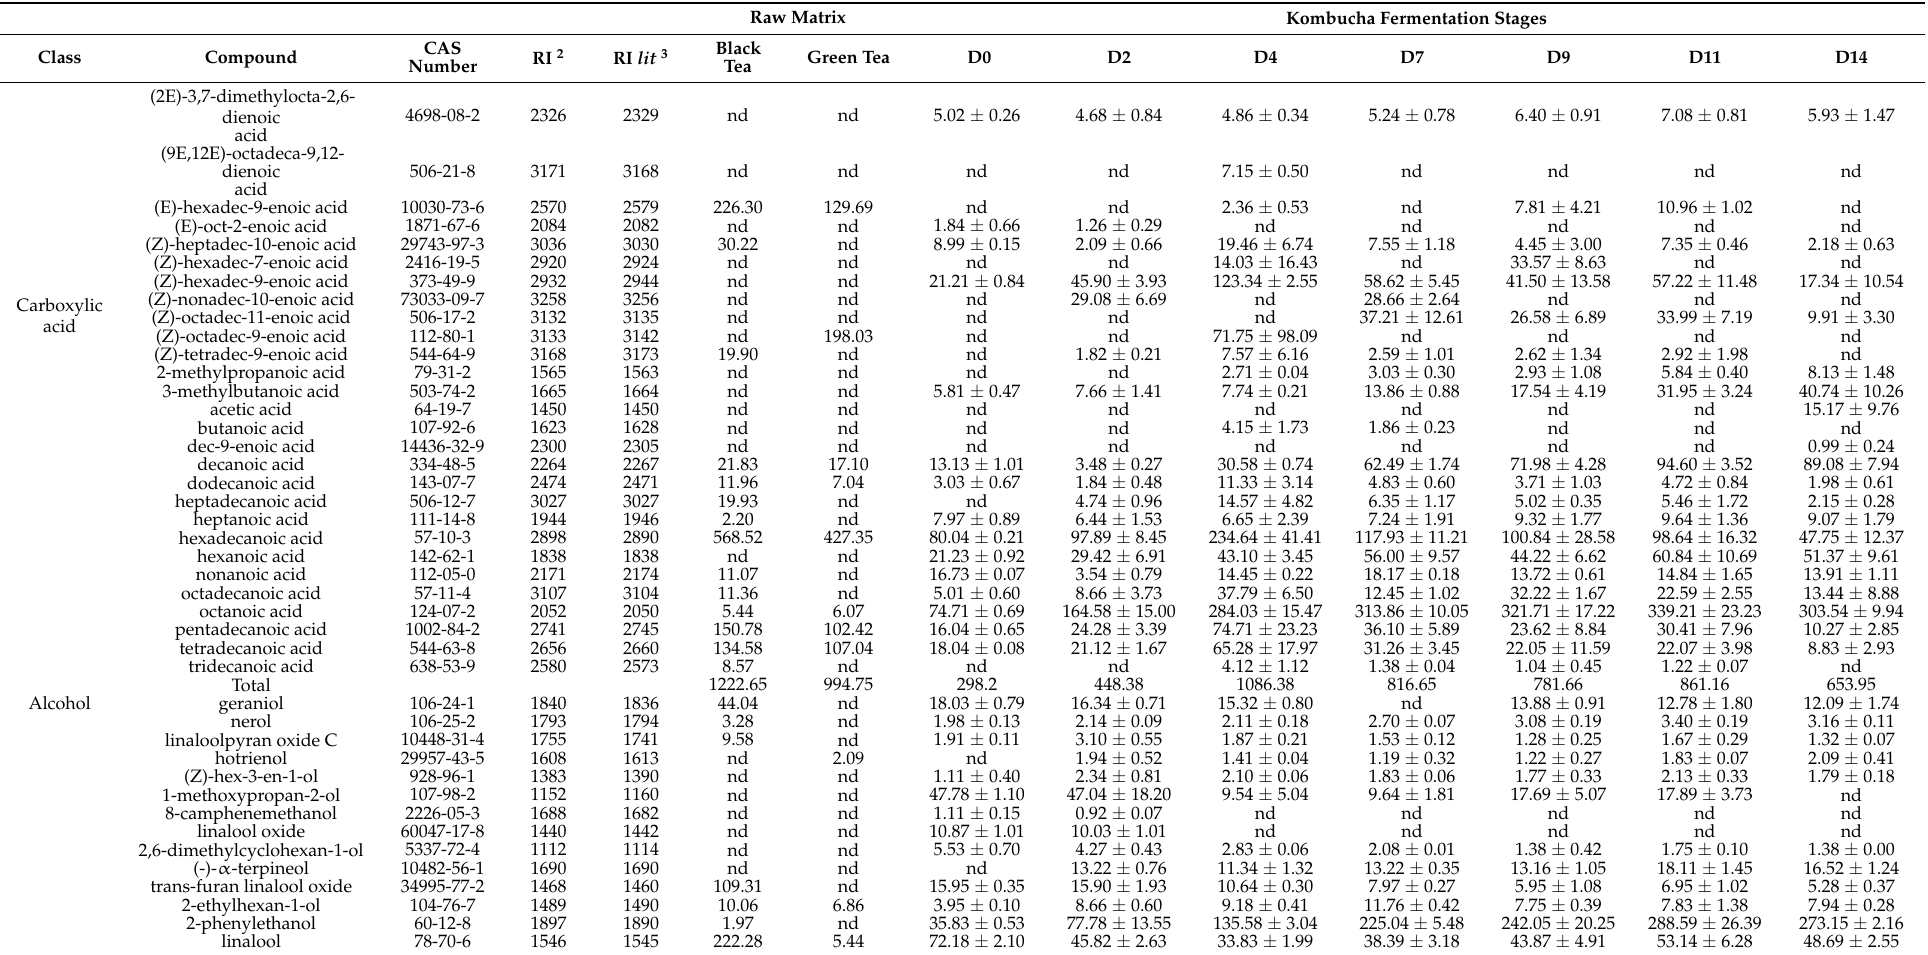
Table 1. Volatile organic compounds contents 1 (ppm) with kombucha fermentation time (day) conducted at 30 ◦